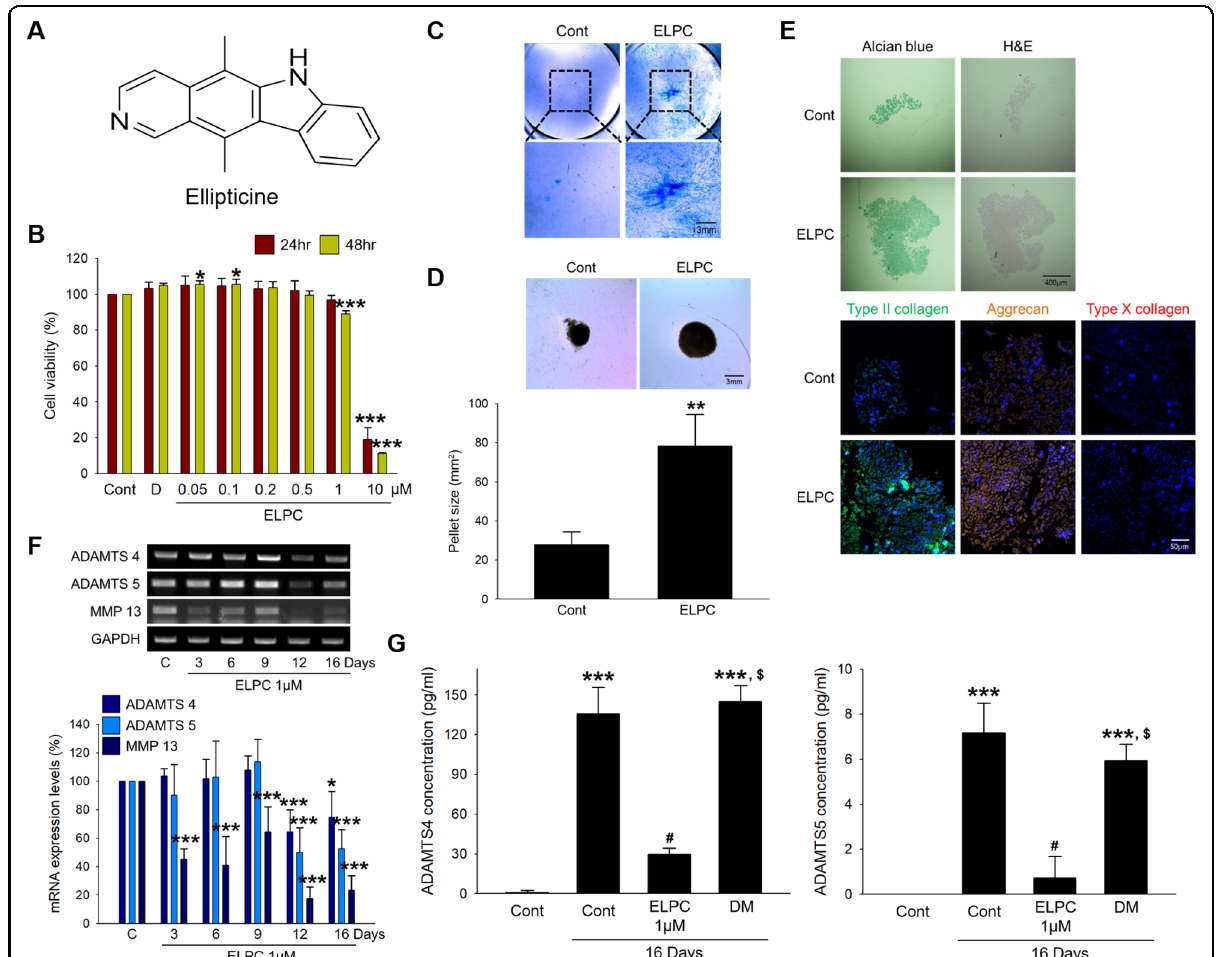
Fig. 3 Ellipticine induces chondrogenic differentiation in ASCs. a Structure of ellipticine. b Concentration-dependent cell viability was measured by cell viability assays in ASCs. D DMSO-treated ASCs * p < 0.05, *** p < 0.001 compared to the control. n = 3. c The ability of ELPC to induce differentiation was con fi rmed using Alcian blue staining after ASCs were incubated with ELPC for 16 days. Scale bar: 3 mm. d A 3D pellet culture was performed using ASCs or ELPC-treated ASCs for 16 days. ** p < 0.01 compared to the control. n = 3. e The untreated ASC and ELPC-treated ASC pellets were stained using Alcian blue and H&E. The expression of Type II collagen, Aggrecan, and Type X collagen was detected by immuno fl uorescence. Nuclei were stained with DAPI (Blue). Scale bar: upper 400 μ m and lower 50 μ m. f The mRNA expression of the extracellular matrix degradation enzymes ADAMTS4, ADAMTS5, and MMP13. Normalized by GAPDH. * p < 0.05, *** p < 0.001 compared to the control. n = 3. g The concentrations of secreted ADAMTS4 and ADAMTS5 were measured by ELISAs. *** p < 0.001 compared to the control, # p < 0.001 compared to the 16-day control, $ p